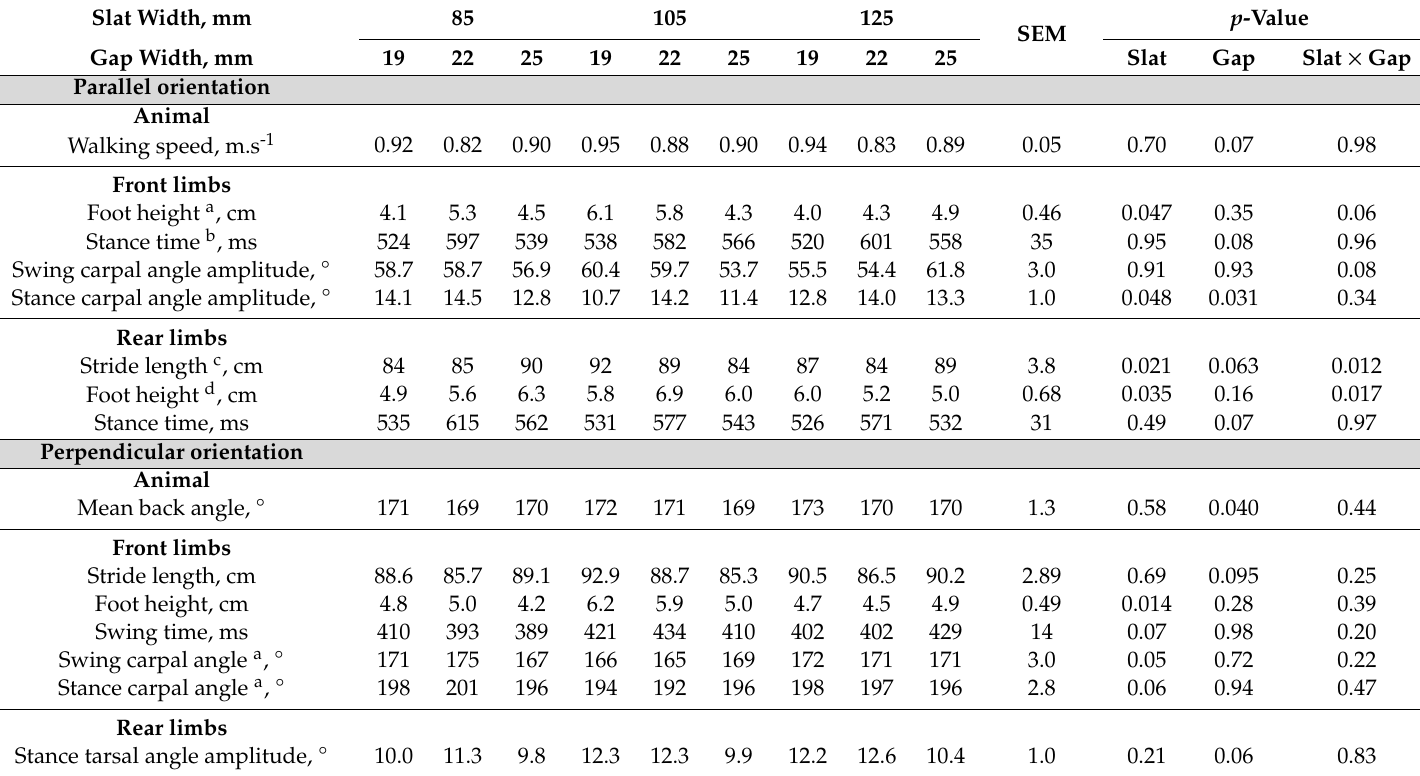
Table 4. E ff ects of slat and gap widths on the gait on sound gilts walking on concrete slats with parallel or perpendicular